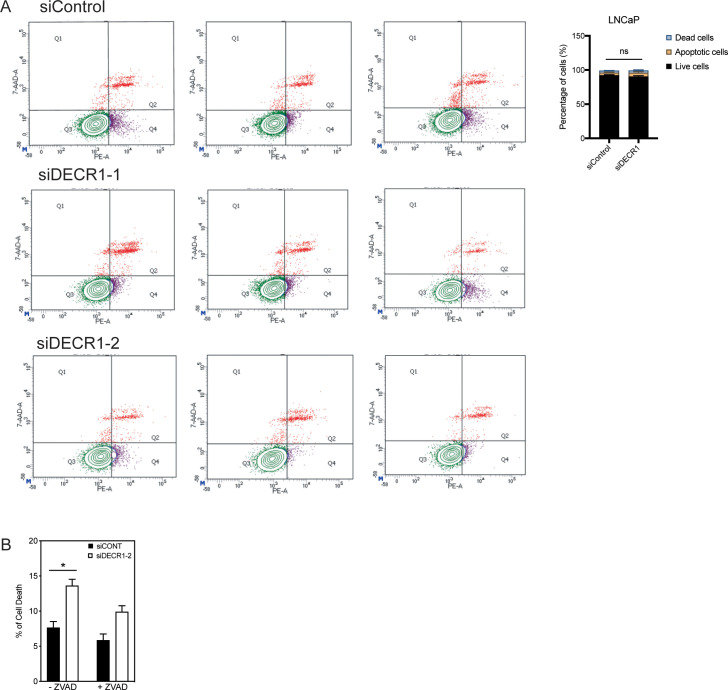
Targeting DECR1 does not induce apoptosis of prostate cancer cells.(A) LNCaP cells were stained with AnnexinV-Phycoerythrin (PE)/7-Aminoactinomycin D (7-AAD) followed by flow cytometry analysis after 96 hr DECR1 knockdown to detect apoptotic cells. (B) Cell death after DECR1 knockdown in LNCaP cells treated with or without the caspase inhibitor (ZVAD) measured using trypan blue exclusion.